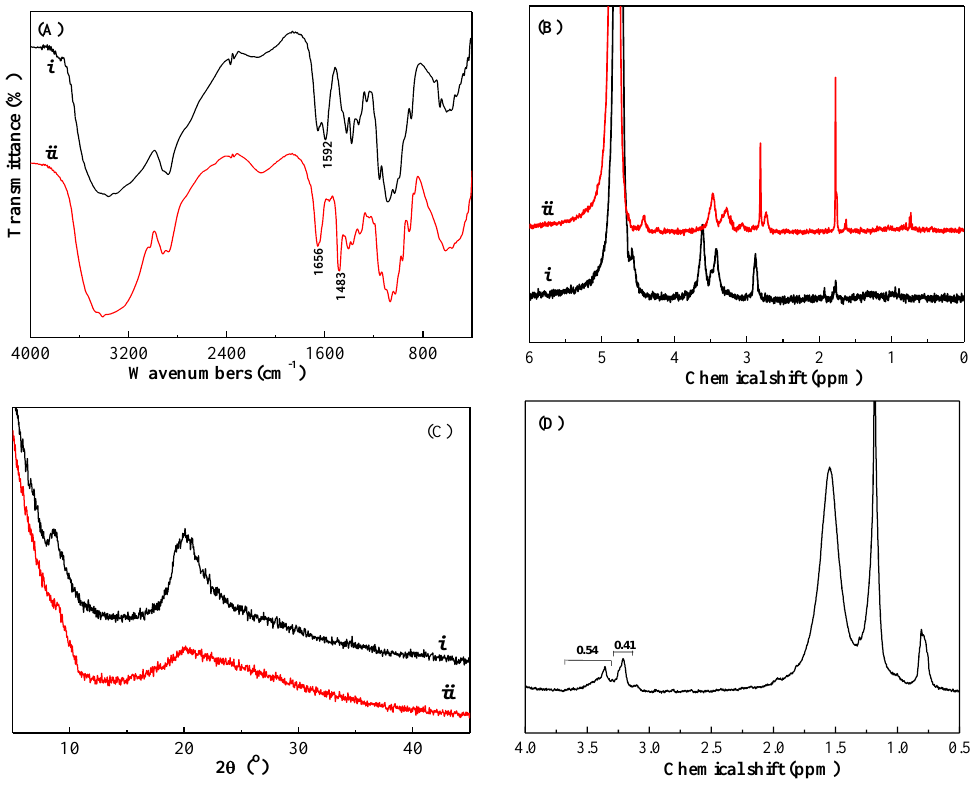
Figure 1. FTIR ( A ), 1 H NMR ( B ) spectra and XRD patterns ( C ) of chitosan ( i ) and GTA-m-CS ( ii ) and 1 H NMR spectra of DDEAC ( D ).